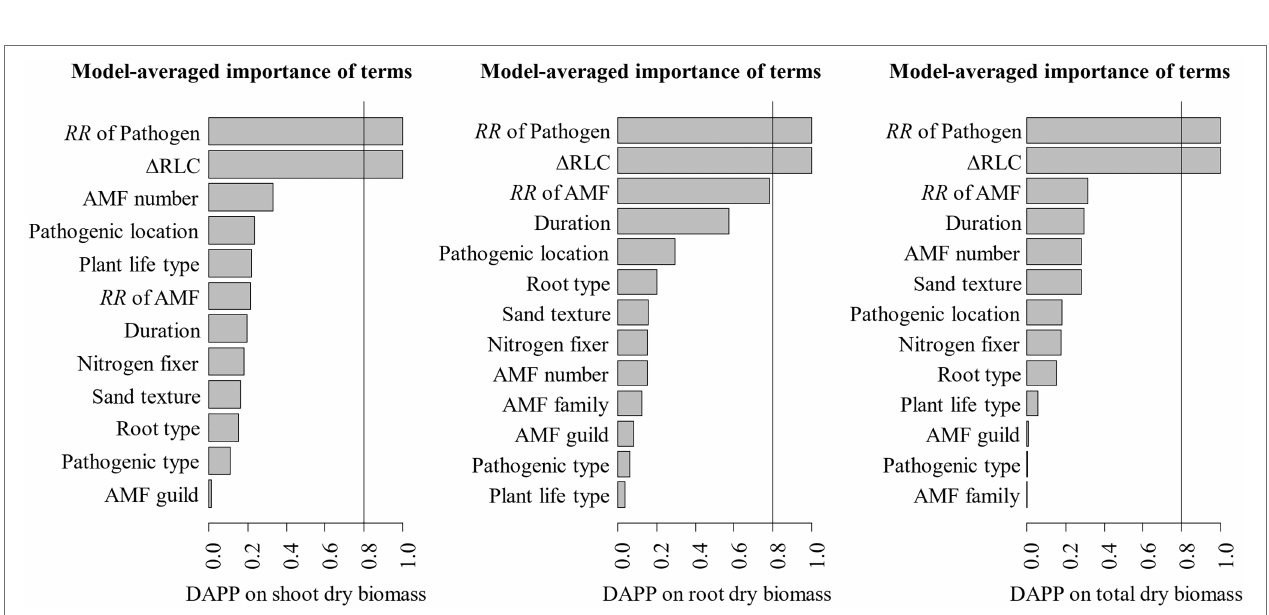
FIGURE 3 | The difference of the effect size of AMF on the plant biomass under plant pathogenic microbes and no-pathogenic condition (DAPP). Values near the error bar were numbers of observations included in the analysis.